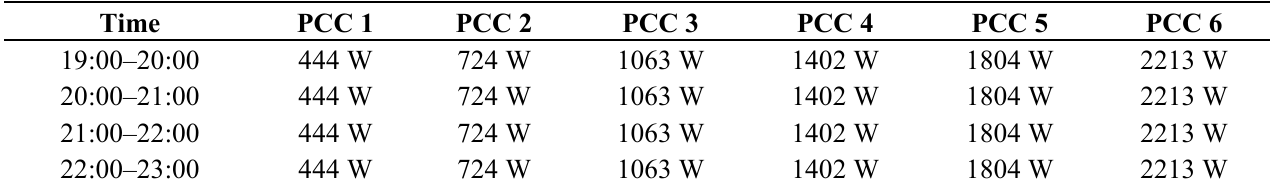
Table 6. ESS equally discharging schedule between 7 and 11 pm.